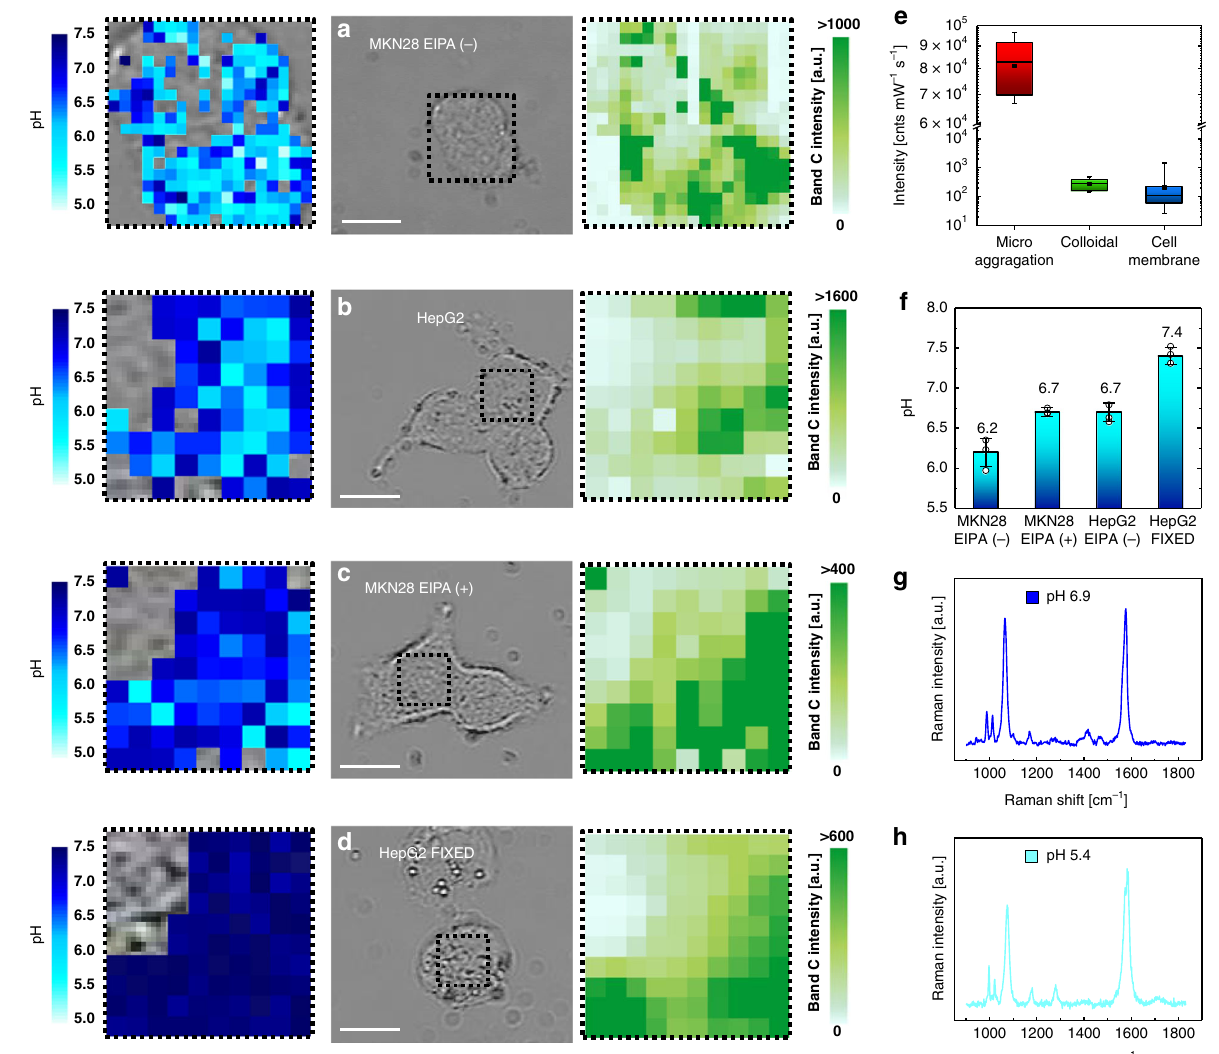
Fig. 9 Results of cell surface pH analyses using SERS. a – d Examples of SERS hyperspectral pH mapping on MKN28, HepG2, MKN28 30 min after the application of EIPA and HepG2 after fi xation, respectively. Each point of the maps corresponds effectively to a spot of 700 nm diameter. The relative images of Raman intensity of Band C at 1068 cm − 1 are also reported. Scale bars: 10 µ m. e Box plot comparing the integrated intensities at 1068 cm − 1 collected from micro-aggregations ( n = 9 measurements), AuNP colloidal solutions ( n = 9 measurements) and AuNP on cell membrane surface ( n = 864 measurements). The whiskers represent maximum and minimum; the square dot shows the mean and the segment in the rectangle indicates the median. f Mean values of surface pH in the four investigated cases (error bars show the standard deviation from the mean of n = 3 independent experiments). g – h Examples of SERS spectra collected from the outer surface of the cells and representative of pH 6.9 and 5.4, respectively. The band A + B was barely observable in the exemplifying spectrum of h . Source data are provided as a Source Data fi le. Source dataSource